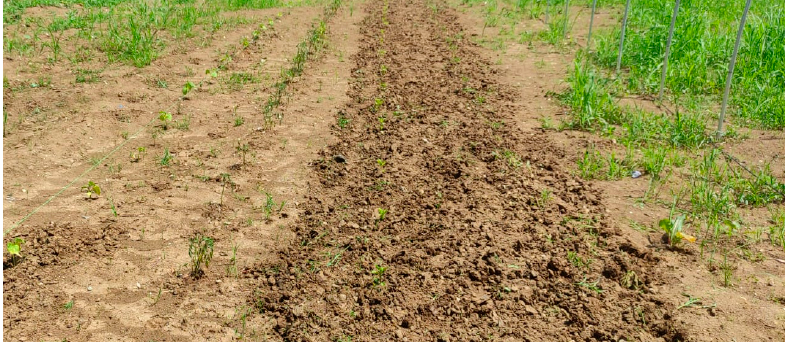
Figure 10. Establishment of vegetable experimental cultures for evaluating the effectiveness of bioactive compounds.